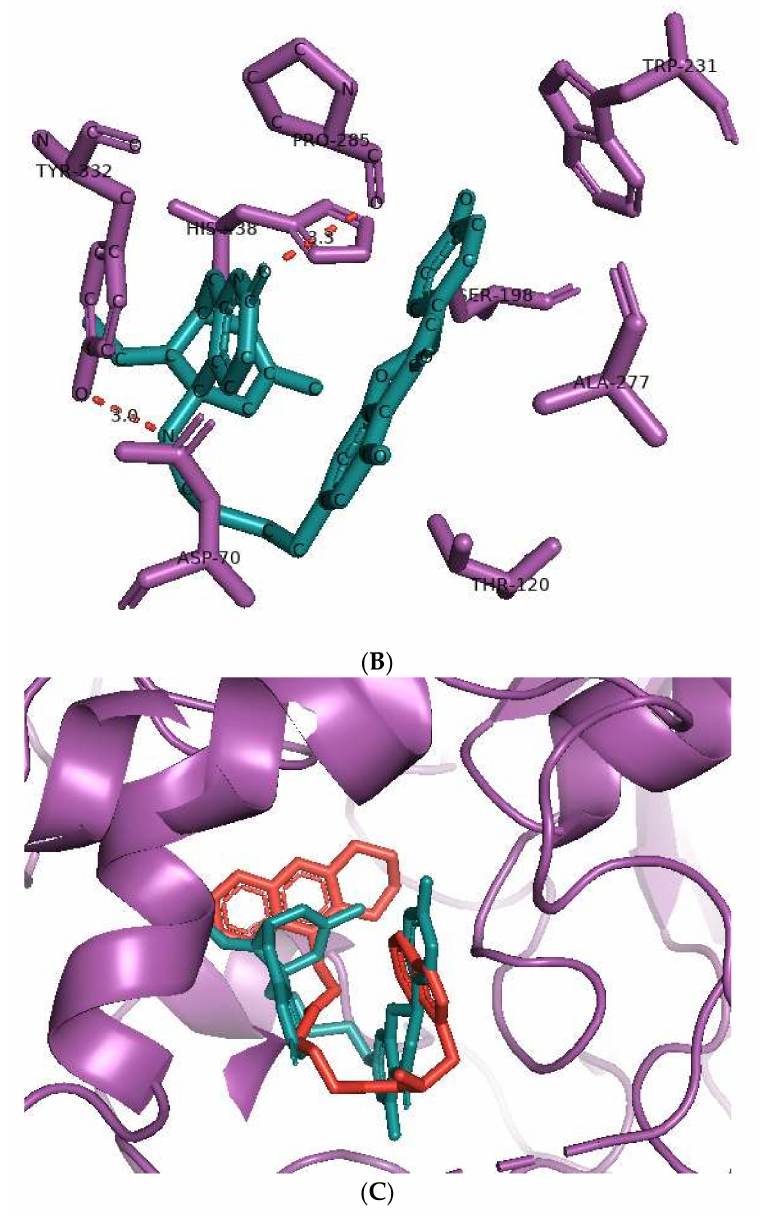
Figure 3. Docking models of huperzine-4C-naringenin (colored cyan) binding to the active site of BuChE enzyme (colored purple). ( A ) Binding pose of huperzine-4C-naringenin looking down the catalytic gorge of BuChE. ( B ) Ligand huperzine-4C-naringenin (cyan colored sticks) docked with binding site residues of BuChE. Hydrogen bonding is represented by red lines and the distance mea- sured in Å. ( C ) Huperzine-4C-naringenin superimposed with a chlorotacrine-tryptophan heterodimer pre-bound with the crystal structure of the BuChE enzyme target (PDB ID: